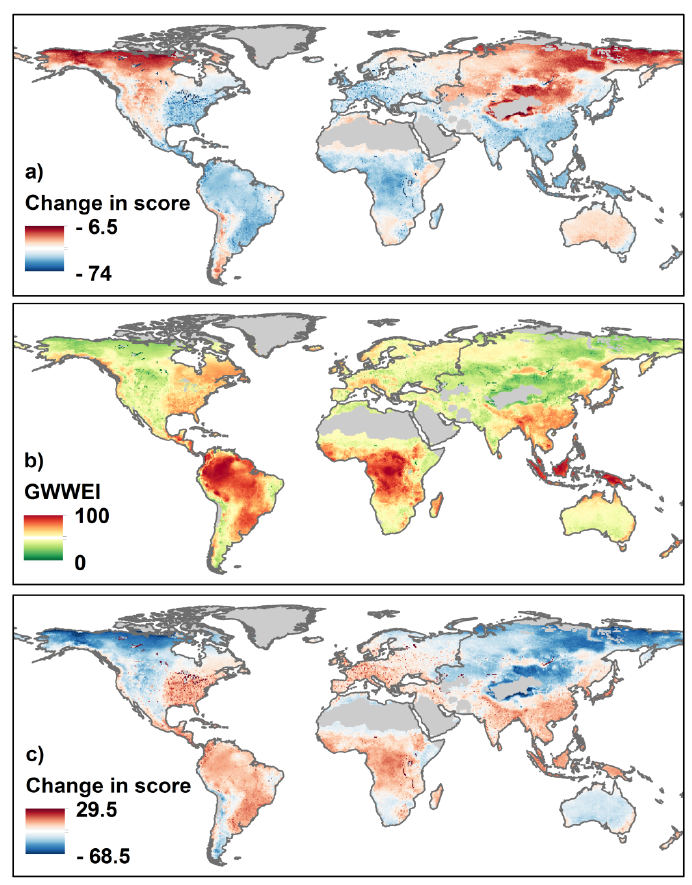
Figure 6. Map set of the relative change (%) in final GWWEI scores using the low case ( a ) and high case ( c ) scenario mode in the sensitivity analyses. The role of water resource indicators is made clear by the pattern of change when compared with the GWWEI ( b) .